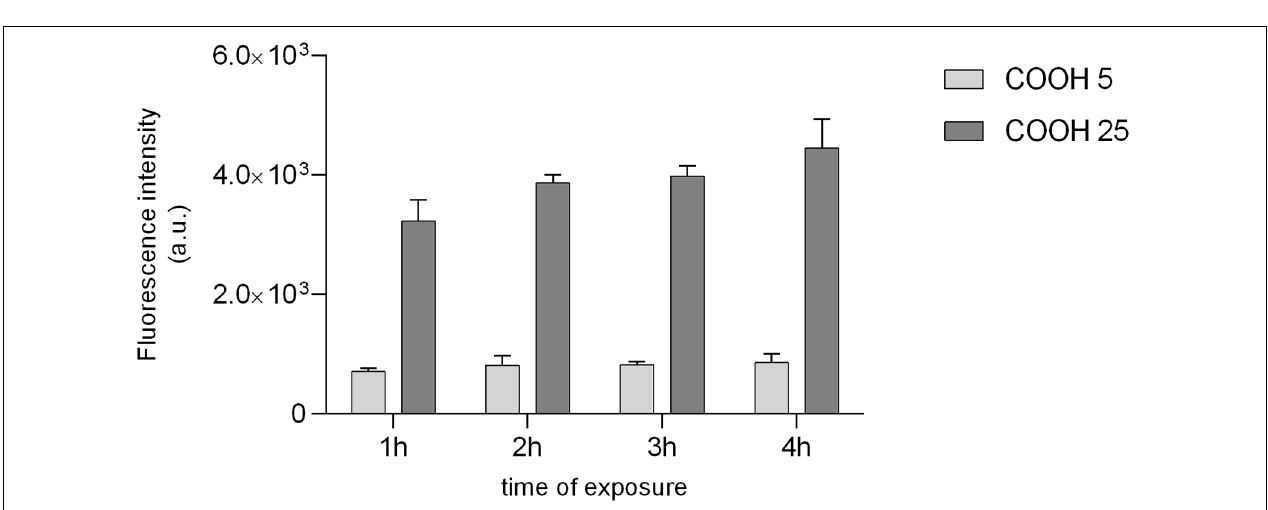
FIGURE 5 | Uptake of PS-COOH in sea urchin phagocytes. Fluorescence intensity (arbitrary units, a.u.) of immune cells exposed to fluorescently labeled PS-COOH (5 and 25 µ g mL − 1 ) at 0 h and after 1, 2, 3, and 4 h of exposure. Bars represent mean ± SD ( n = 3). Fluorescence intensity values are normalized to the auto-fluorescence signal of the control group ( P. lividus cells exposed to CF only) at each